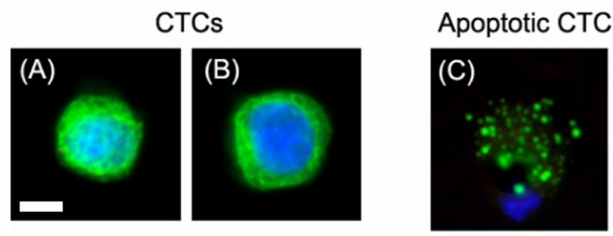
Figure 1. ( A , B ): Pathologically defined CTCs, where CK8, 18, 19 have a filamentous structure. CTCs do not express CD45. DAPI (blue), CK8, 18, 19 (green), and CD45 (violet). ( C ): Apoptotic CTC, where CK8, 18, 19 appear as dots. The scale bar is 10 µ